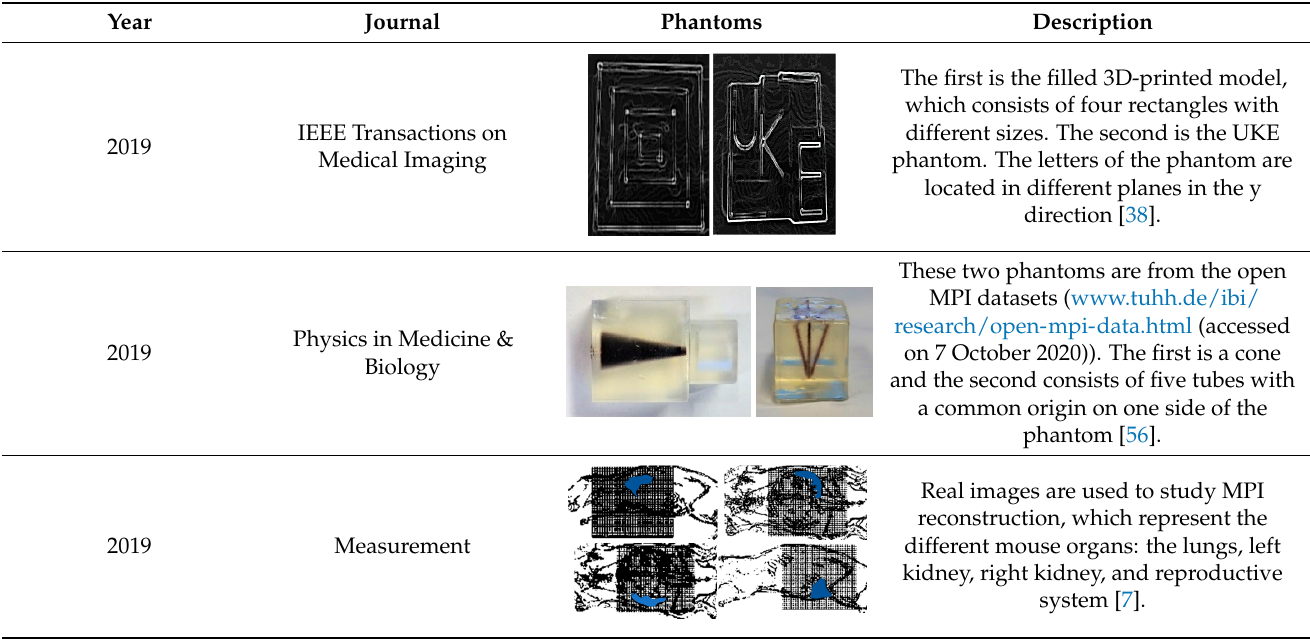
Real images are used to study MPI reconstruction, which represent the different mouse organs: the lungs, left kidney, right kidney, and reproductive system [7].